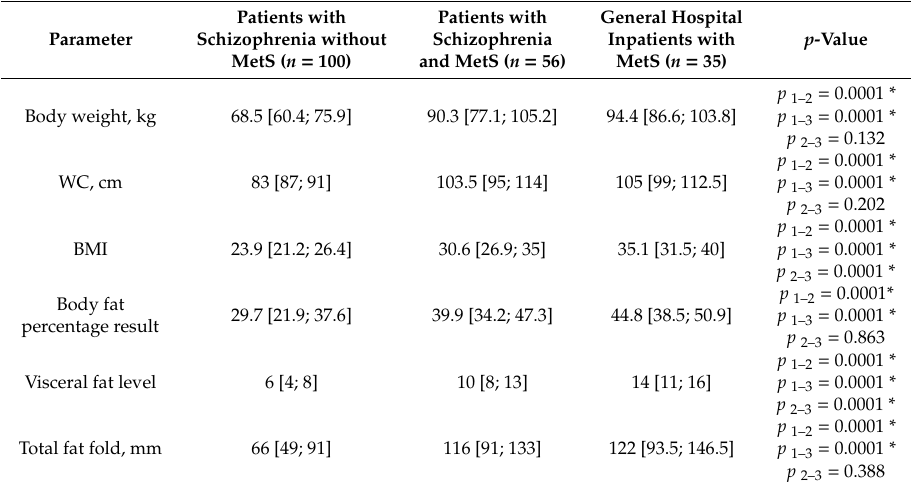
Table 3. Body fat composition parameters (Me [Q1;